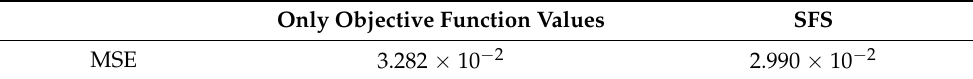
Table 4. MSE results of machine learning to small-scale problems for 2 objectives.